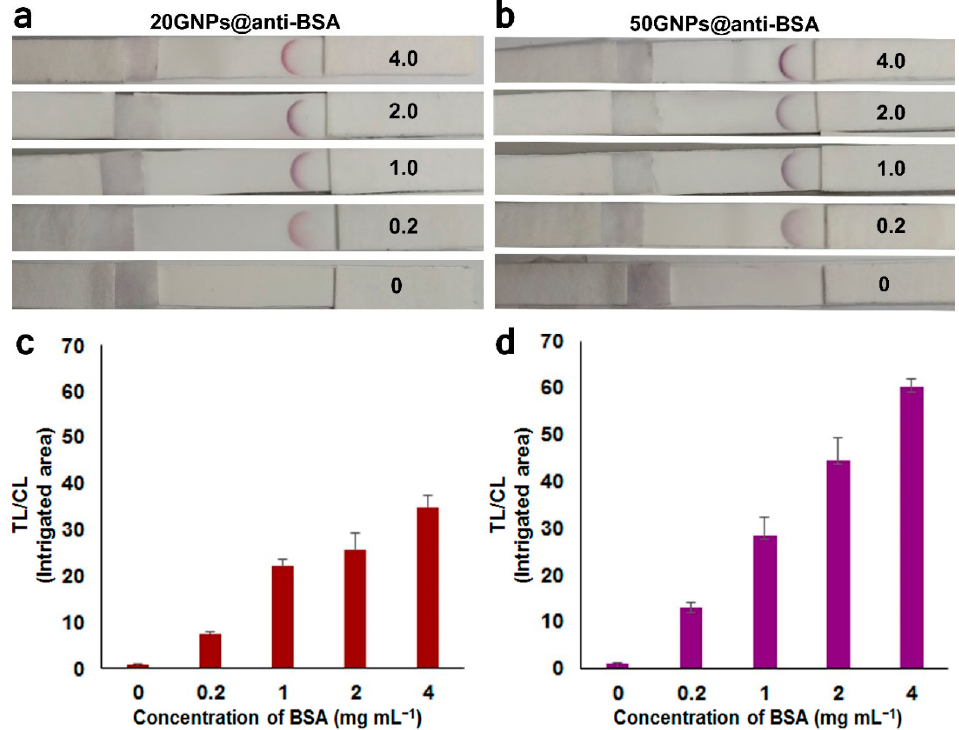
Figure 7. Detection process of BSA molecules with different concentrations (0, 0.2, 1, 2, and 4 mg mL − 1 ) spotted on the test line of the LFA using 20GNPs@anti-BSA and 50GNPs@anti-BSA conjugates immobilized on the test pad as a detecting probe. ( a , b ) Visual detection of BSA molecules on the membrane using 20GNPs@anti-BSA or 50GNPs@anti-BSA conjugates, respectively. ( c , d ). Ratio of the test line intensity (TL) divided by the control line intensity (CL) showing detection signal intensity of BSA molecules using 20GNPs@anti-BSA and 50GNPs@anti-BSA conjugates, respectively. (n ≥ 3).